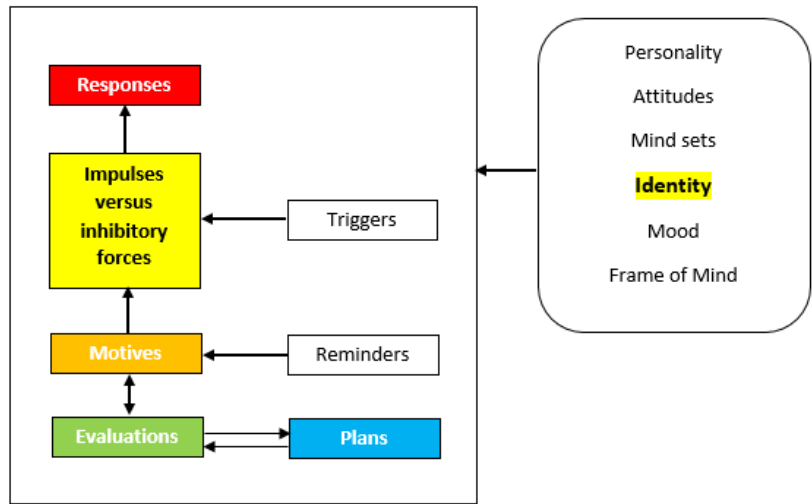
Figure 1. Schematic illustration of five stages in West’s PRIME Theory [2]. Chances for impacts between the stages are demonstrated by their being next to each other in the illustration. For instance, motives could only affect responses through impulses and evaluations could only impact upon responses through motives and then impulses. Plans contribute a framework to our responses but could only affect them through motives and evaluations functioning in the moment when they are to be implemented.